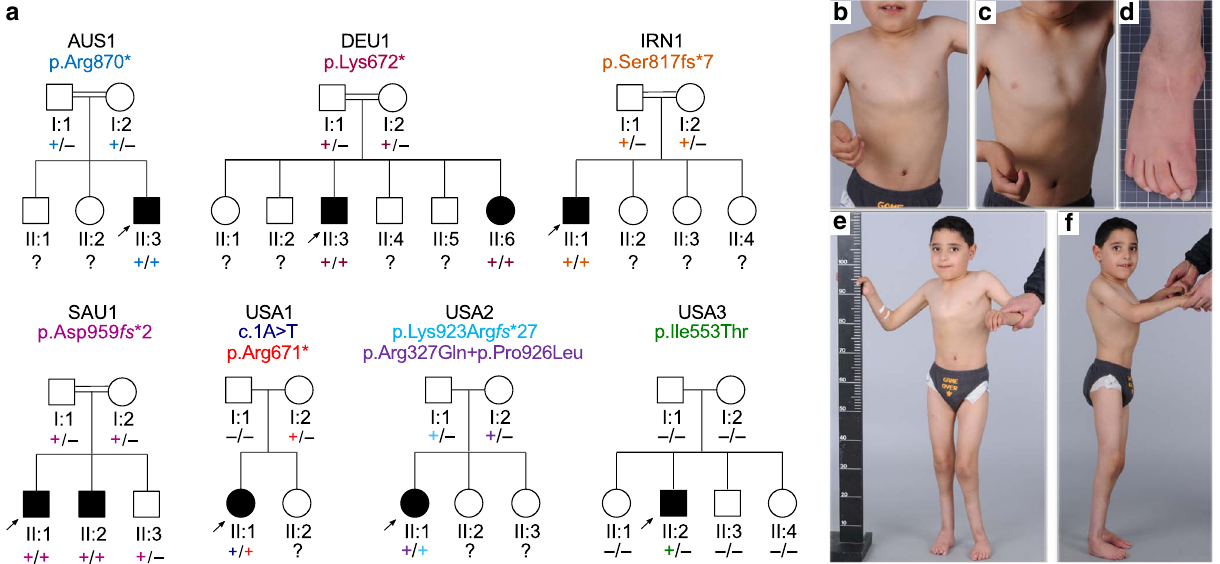
Fig. 5 NEMF variants are associated with neuromuscular disease in humans. a Pedigrees of identi fi ed families having affected individuals and NEMF variants. “ − ” indicates wild-type allele, “ + ” indicates variant allele, arrowhead indicates proband. Different font colors are used to facilitate visualization of the distribution of wild-type ( “ − ” ) and unique mutant ( “ + ” ) alleles in the pedigrees. b – f Clinical photography of 7-year-old subject AUS1-II:3. Asymmetric pectus excavatum, scoliosis ( b ), and characteristic adducted thumb posture are evident ( c ). Right foot showing surgical scars with residual equinovarus foot deformity and toe clawing ( d ). Images showing pectus excavatum, kyphoscoliosis, hip, and knee fl exor contractures with distal muscle wasting and residual equinovarus foot posturing despite previous orthopedic surgery ( e , f